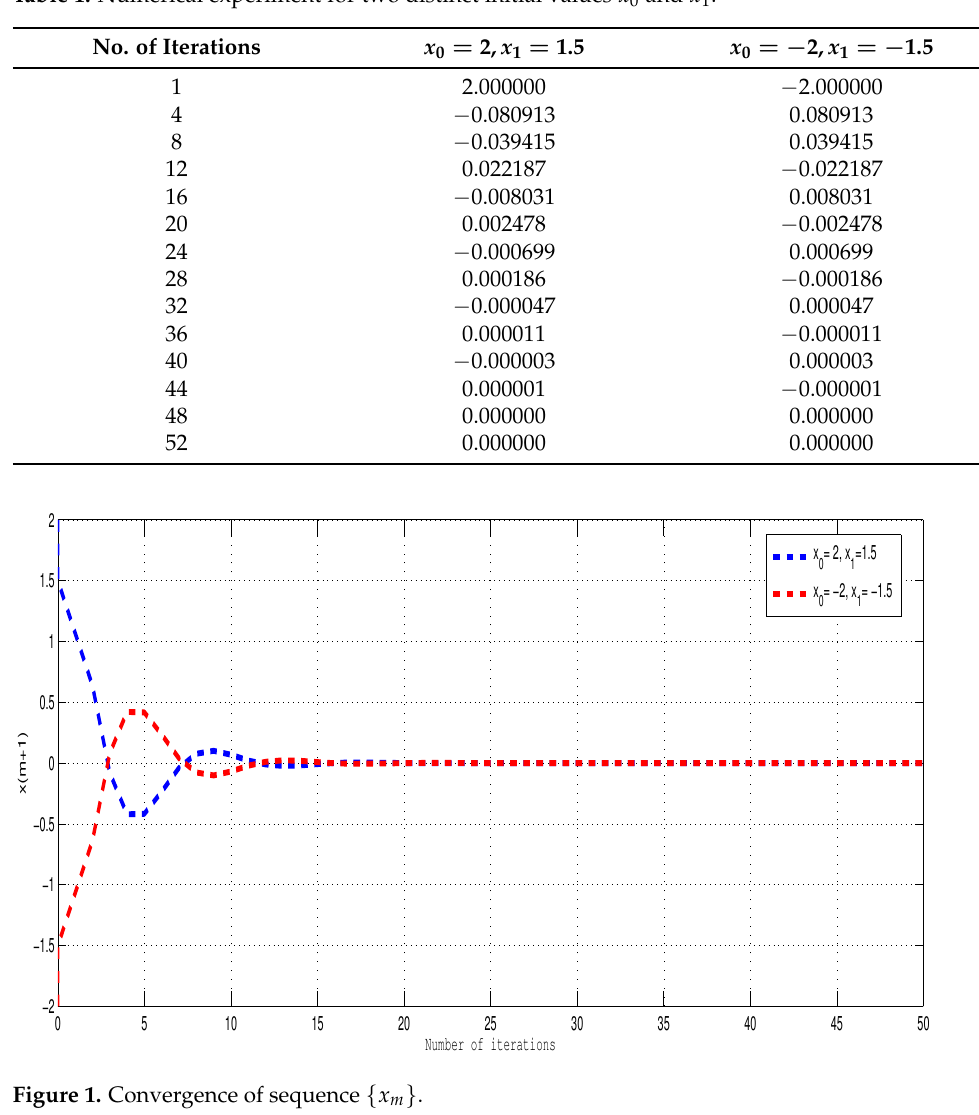
Table 1. Numerical experiment for two distinct initial values x 0 and x 1 .